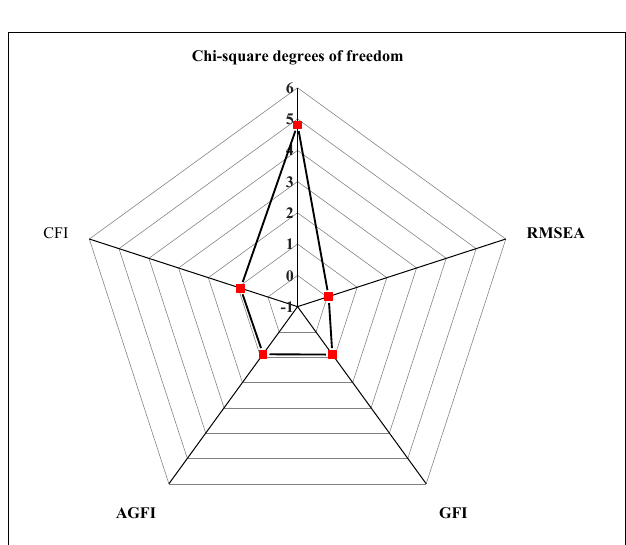
FIGURE 10 | Hypothesis model fitting